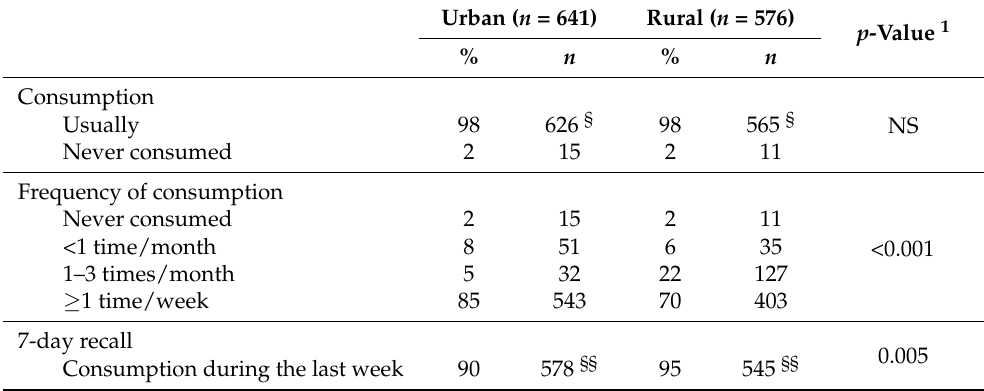
Table 2. Percentages of participants who consumed cowpea-based dishes and the frequency of consumption in the urban area (Cotonou) and the rural areas. Urban ( n = 641) Rural ( n =